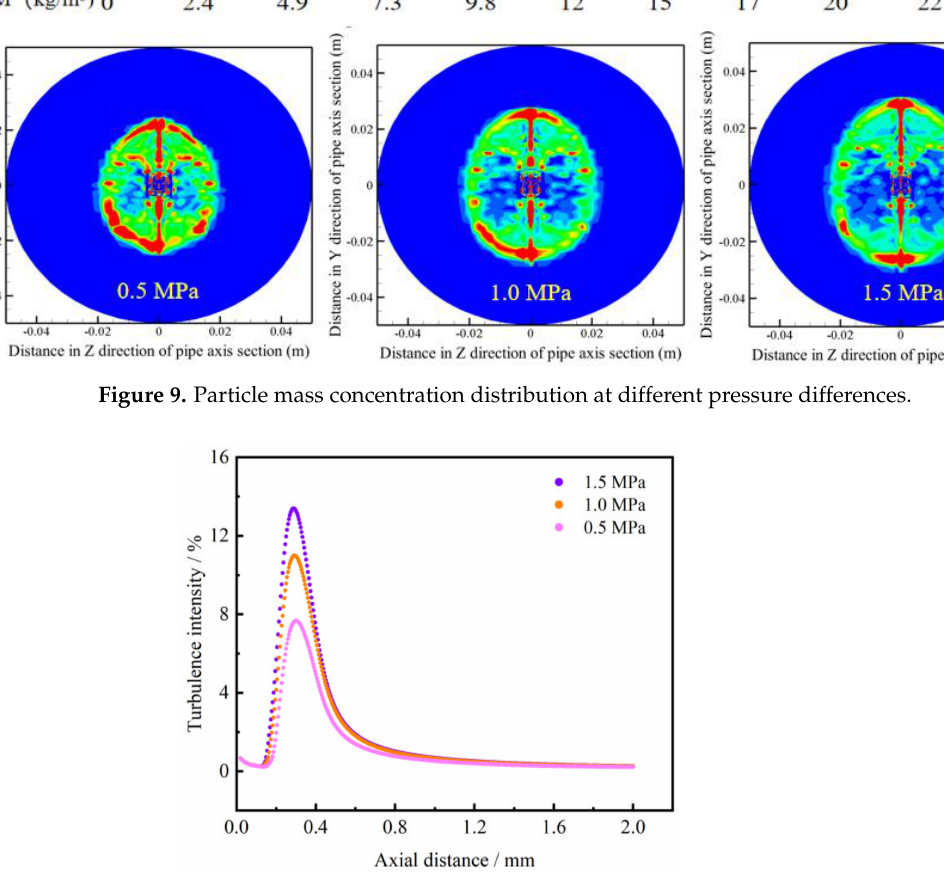
Figure 10. Disturbance range of different pressure difference to main pipeline.